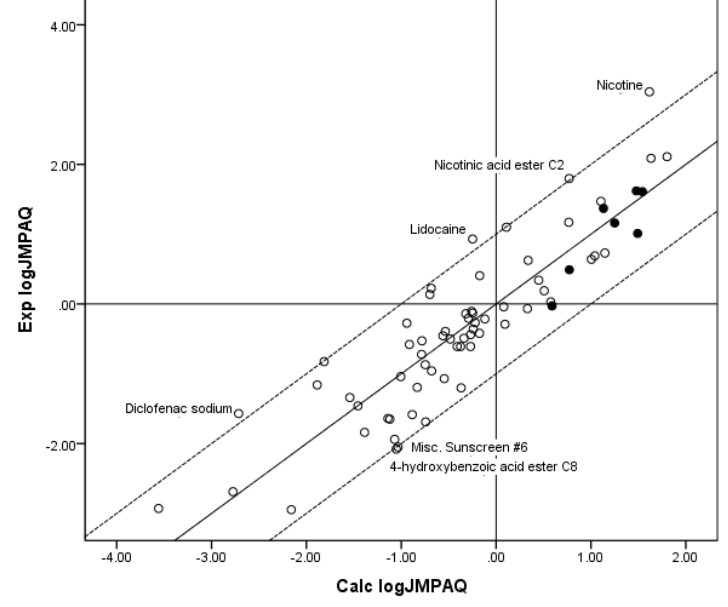
Figure 3 . The correlation of the calculated (Calc.) log J from the fit of n = 70 to KSC MPAQ with the experimental (Exp.) log J . The dashed lines represent the boundaries for MPAQ residual Exp. log J greater than 1.0, the solid line indicates points where the Calc. MPAQ log J is equivalent to the Exp. log J . The filled circles indicate the n = 7 phenols. MPAQ MPAQ The Calc. log J values were determined with Equation MPAQ